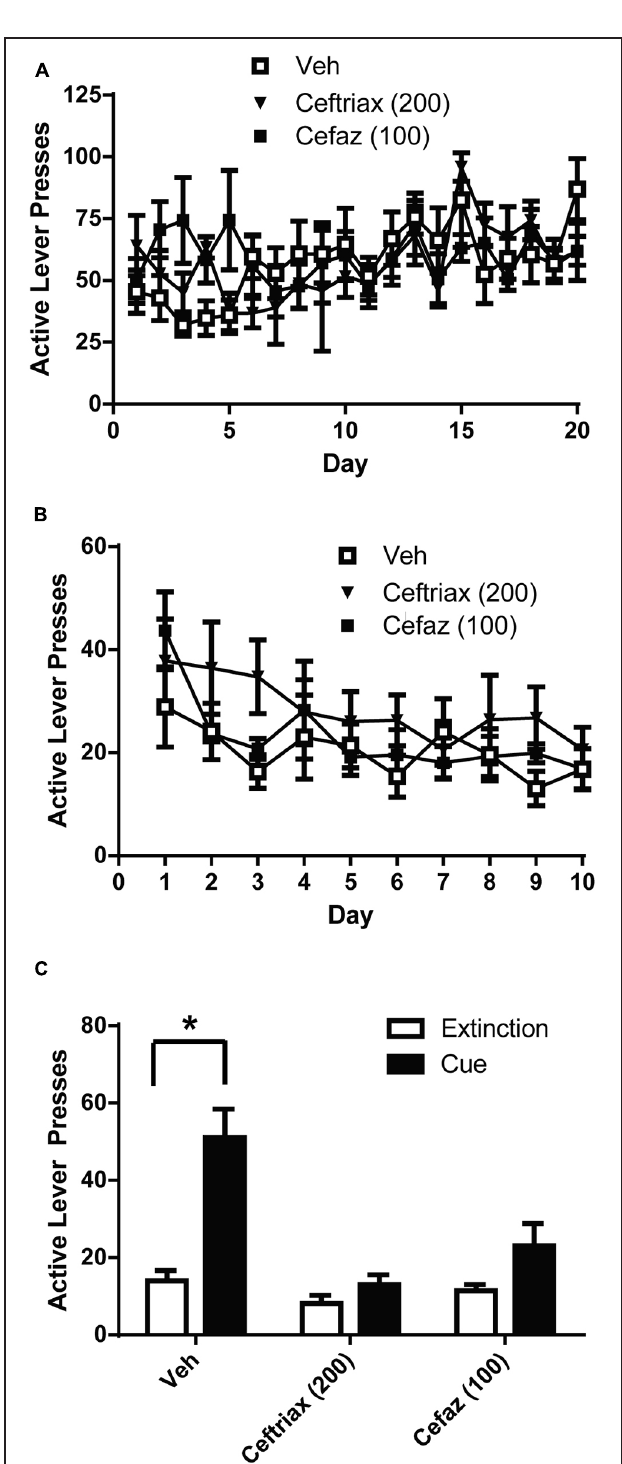
FIGURE 3 | Ceftriaxone and cefazolin attenuated the reinstatement alcohol-seeking. (A) Mean active lever presses during the FR3 portion of the experiment did not differ between groups. (B) Mean active lever presses during extinction training did not differ between groups. (C) Only vehicle-treated animals reinstated lever-pressing during a cue-primed reinstatement test. * p < 0.05 comparing extinction to